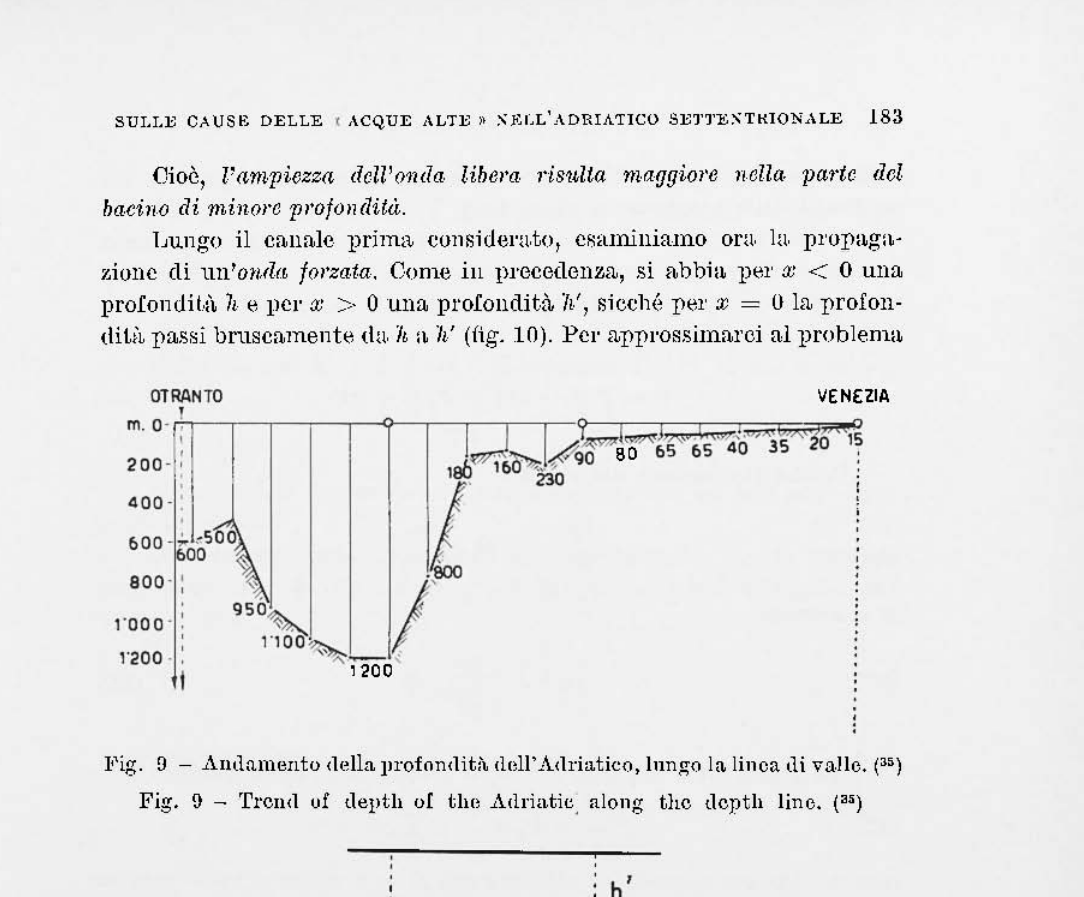
Fig. lO - Scotion and projection or a canal with a stop-shu}wd